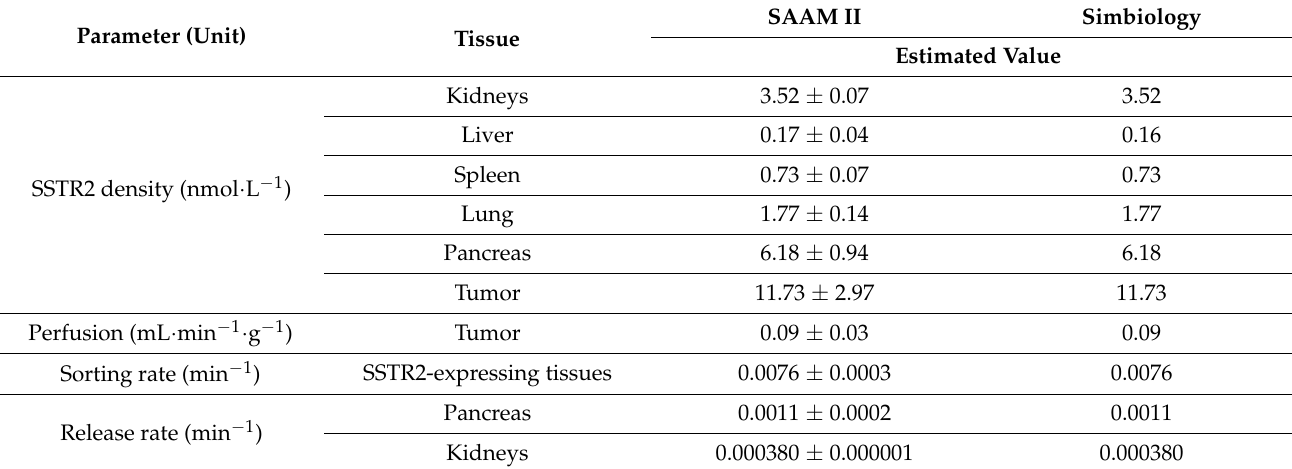
Table 2. Total absorbed dose coefficients (ADC) and the contributions of the in vivo alpha particle generator [ 212 Pb]Pb- DOTAMTATE and its radioactive decay products to the total absorbed doses in SSTR2-expressing and non-SSTR2-ex- pressing tissues.